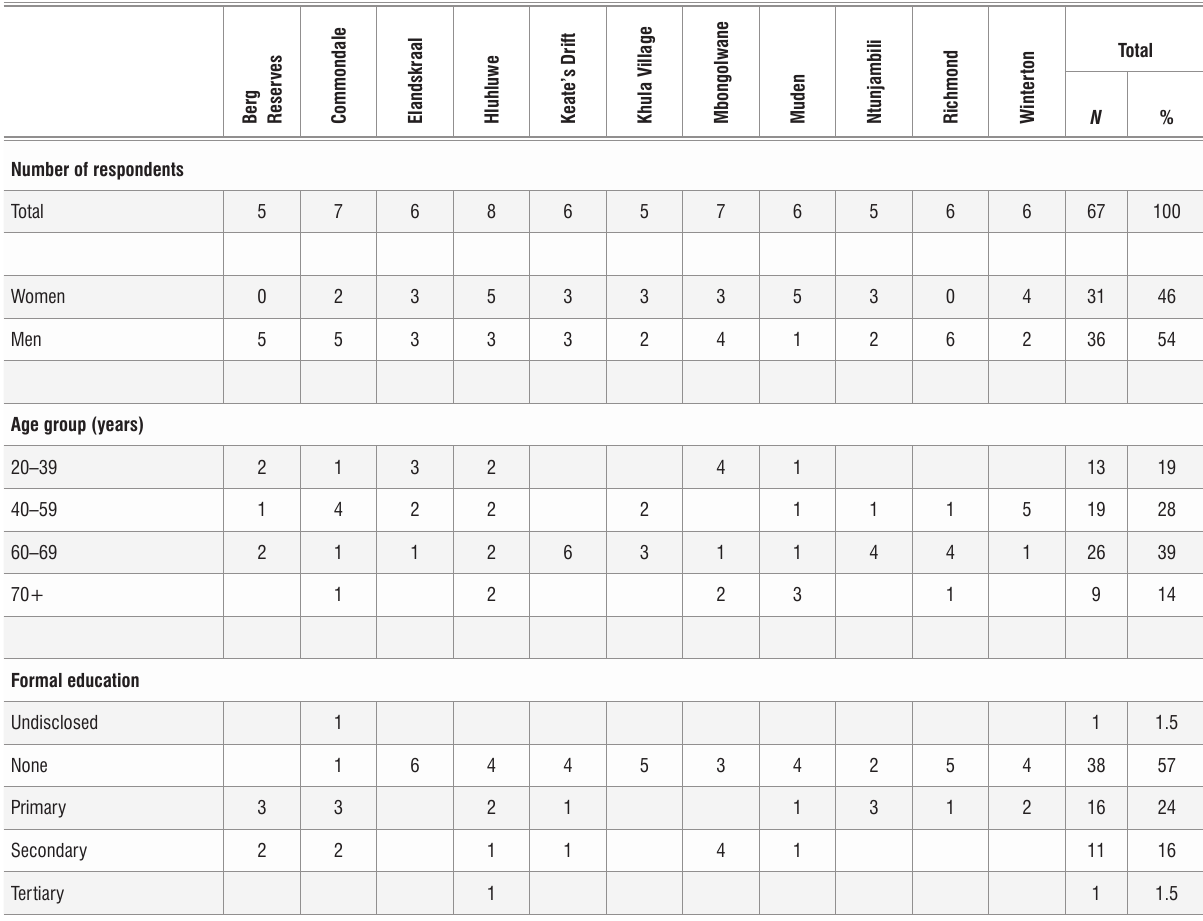
Biographical profiles of amaZulu respondents in 11 communities located in KwaZulu-Natal (Figure